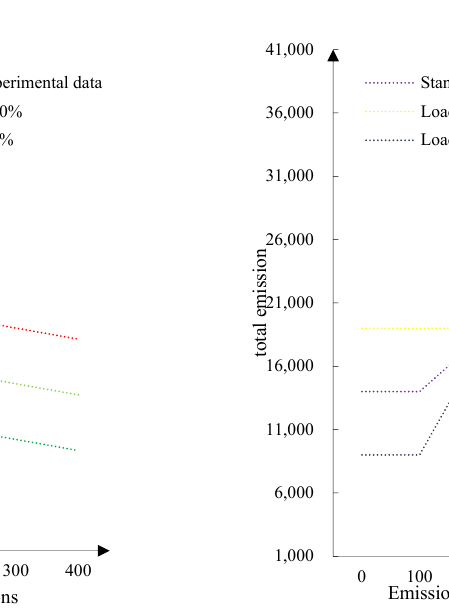
Figure 8. Effects on path emissions at different load rates.